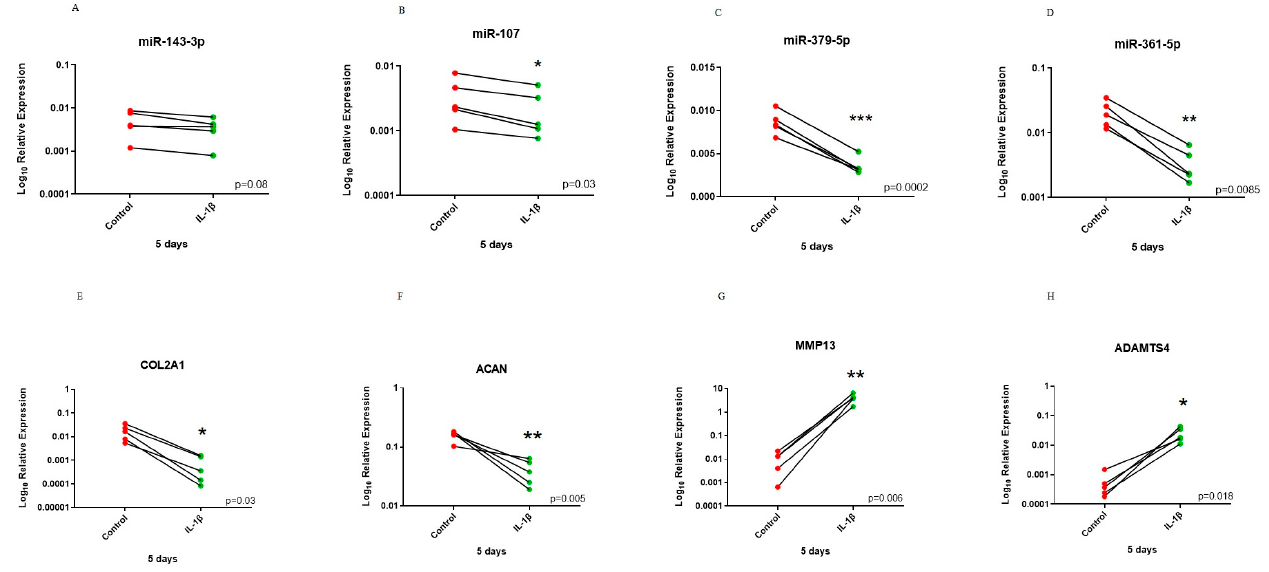
Figure 6. Before–after plot showing expression of selected miRNAs and cartilage markers in human OA chondrocytes treated with 10 ng/mL IL-1 β for 5 days. Human OA chondrocytes were treated with 10 ng/mL human recombinant IL-1 β for 5 days and expression of selected miRNAs; ( A ) miR-143-3p, ( B ) miR-107, ( C ) miR-379-5p and ( D ) miR-361-5p and cartilage markers; ( E ) COL2A1 , ( F ) ACAN , ( G ) MMP13 and ( H ) ADMATS4 was measured ( n = 5 donors). Y axis represents log-transformed expression relative to SNORD68 for miRNAs and relative to GAPDH for OA markers. Statistical analysis was undertaken using a two-tailed paired t-test in GraphPad Prism (Version 8.0.1). p values < 0.05 were considered significant. *: p < 0.05, **: p < 0.01, ***: p < 0.001. Each line connects the control (red) and treated group (green) of the same donor.